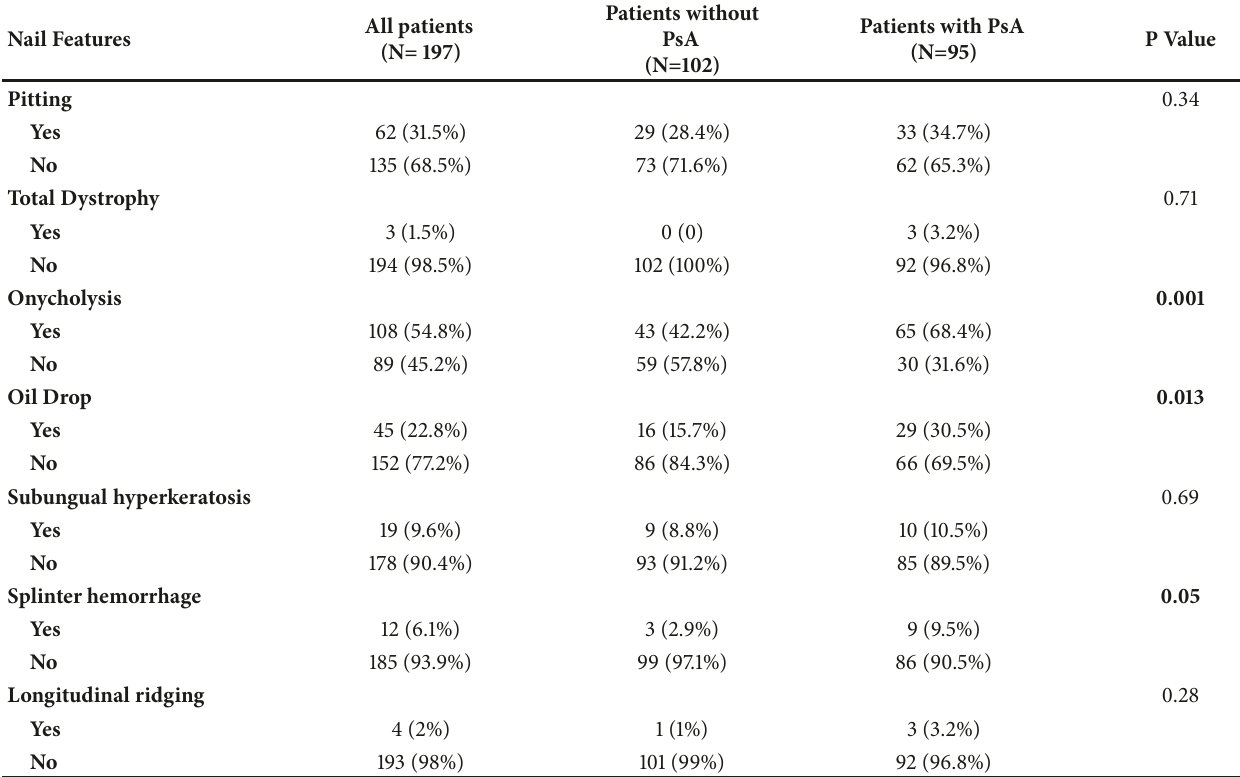
Table 3: Morphologic features of nail